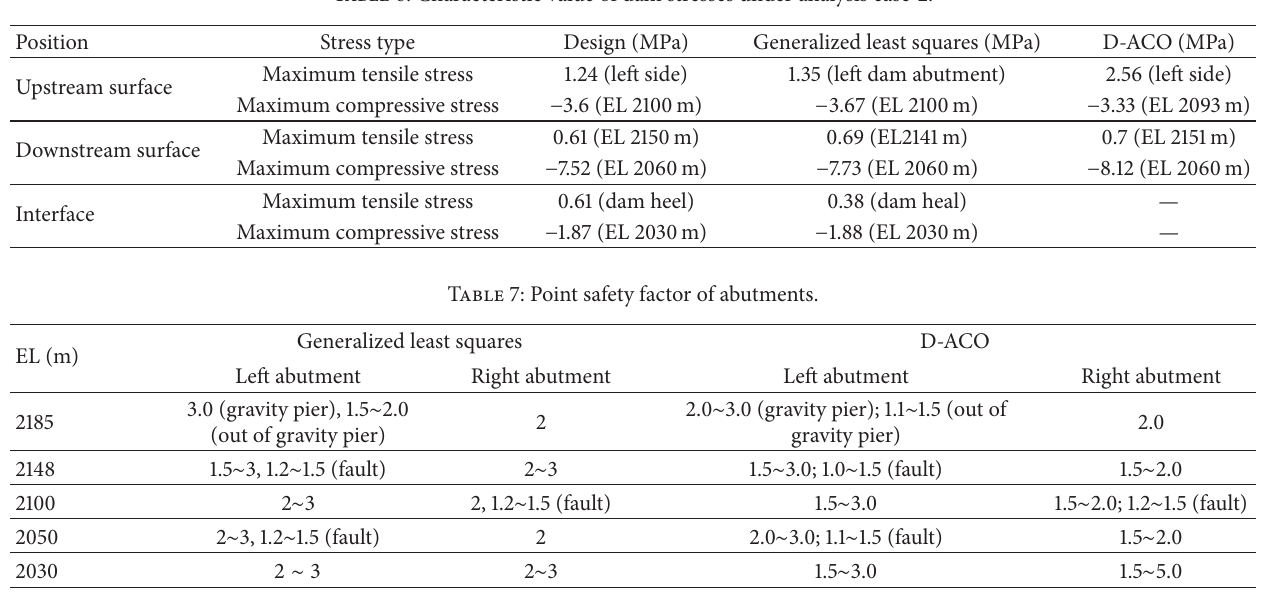
Table 6: Characteristic value of dam stresses under analysis case 2.